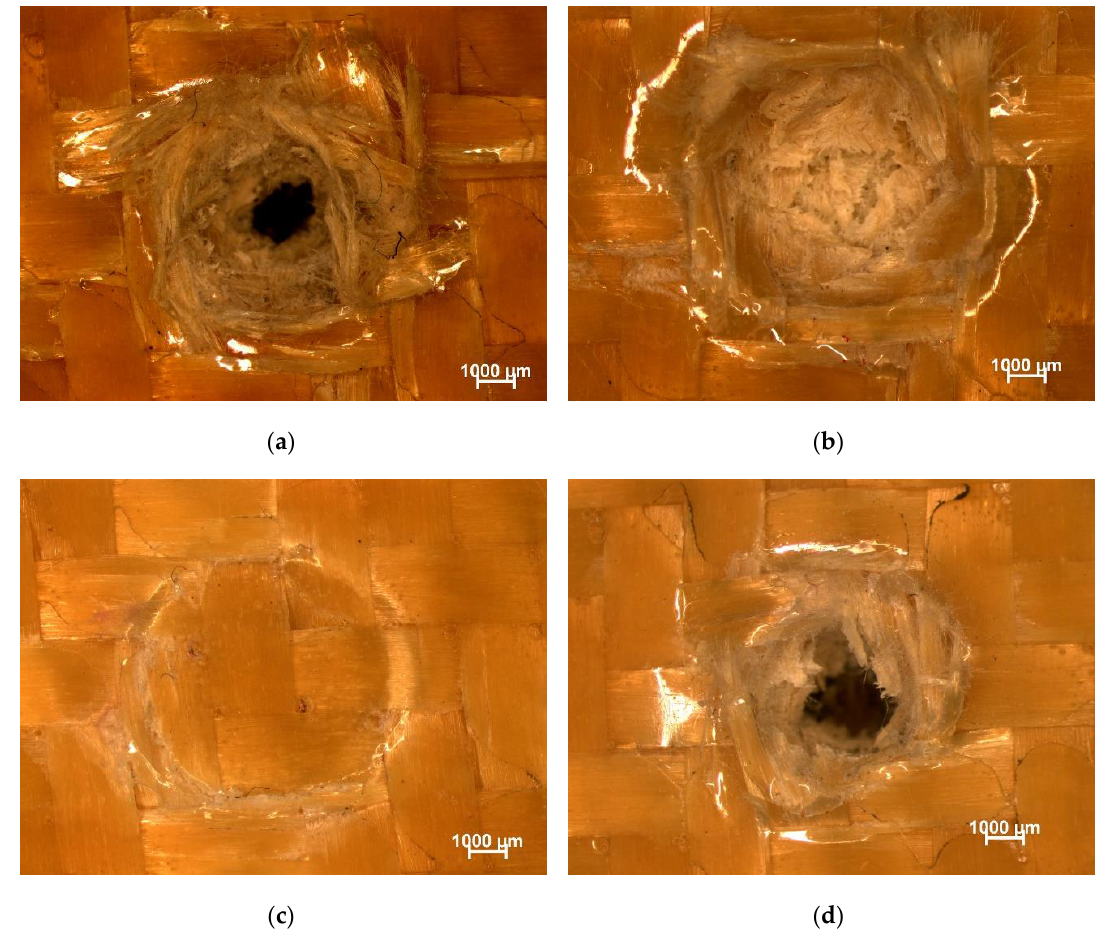
Figure 4. Selected samples after impact of the striker: ( a ) conical, ( b ) hemispherical, ( c ) blunt, ( d ) ogival.